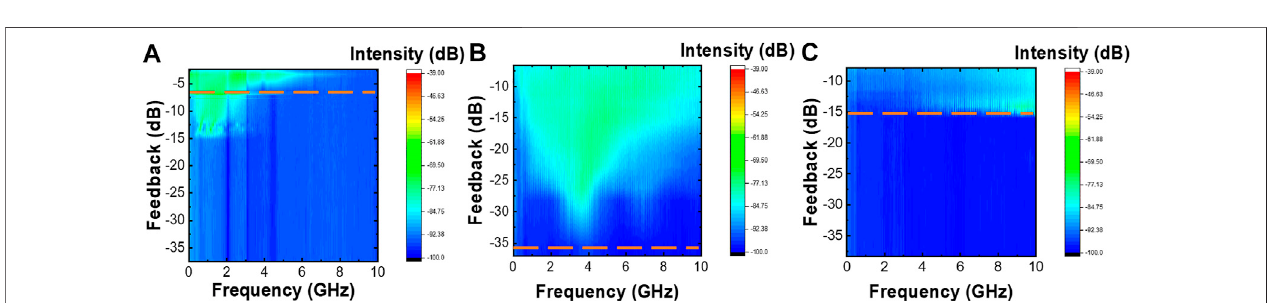
FIGURE 4 | The evolution of electrical spectra of (A) the QD FP laser; (B) QW FP laser; and (C) QW DFB laser.